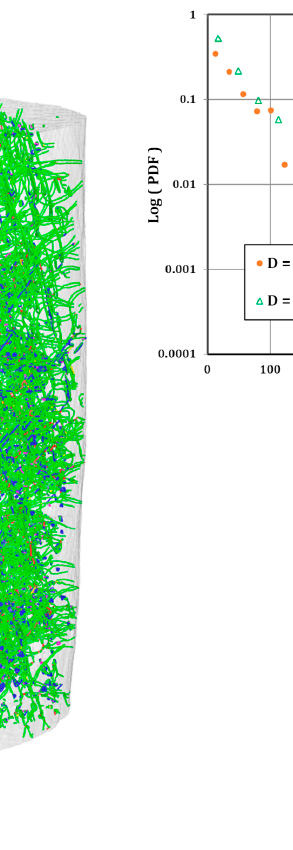
Figure 24. Probability distribution function of dislocation length at different strain rates and pillars with the diameters of: ( a ) D = 45 nm; ( b ) D = 150 nm (after Voyiadjis and Yaghoobi [16]).